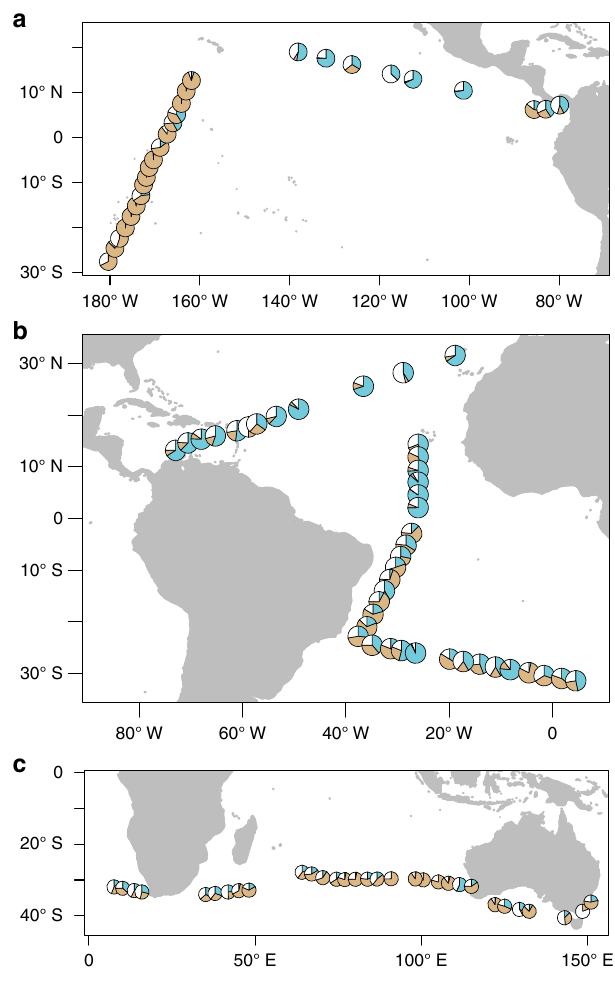
Figure 3 Origin of the prokaryotic sequences. The pie charts represent the estimated proportion contributed by marine ( blue ), terrestrial ( brown ) and unknown ( white ) sources for the 99 sampled locations over the Paci fi c a , Atlantic b and Indian c oceans where we could get sequence information. Please note that the different panels have different scales. Data available